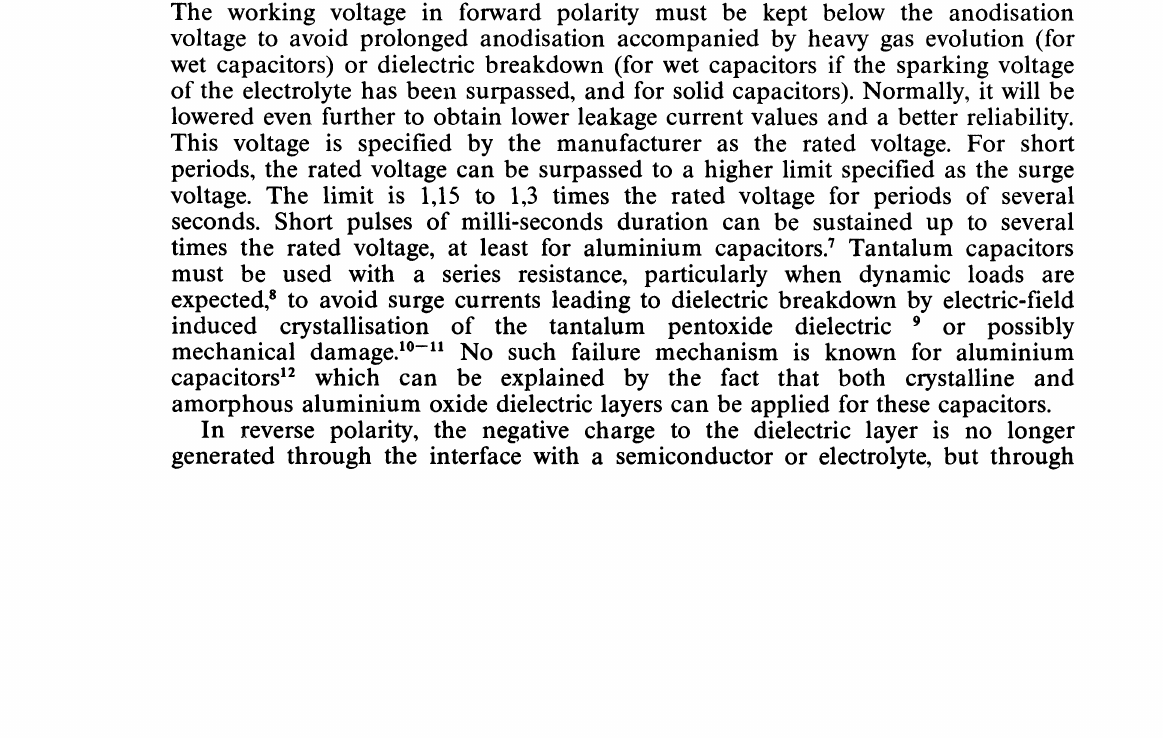
Typical ESR at 100 Hz, as a function of ambient temperature for lacquered pearl solid aluminium